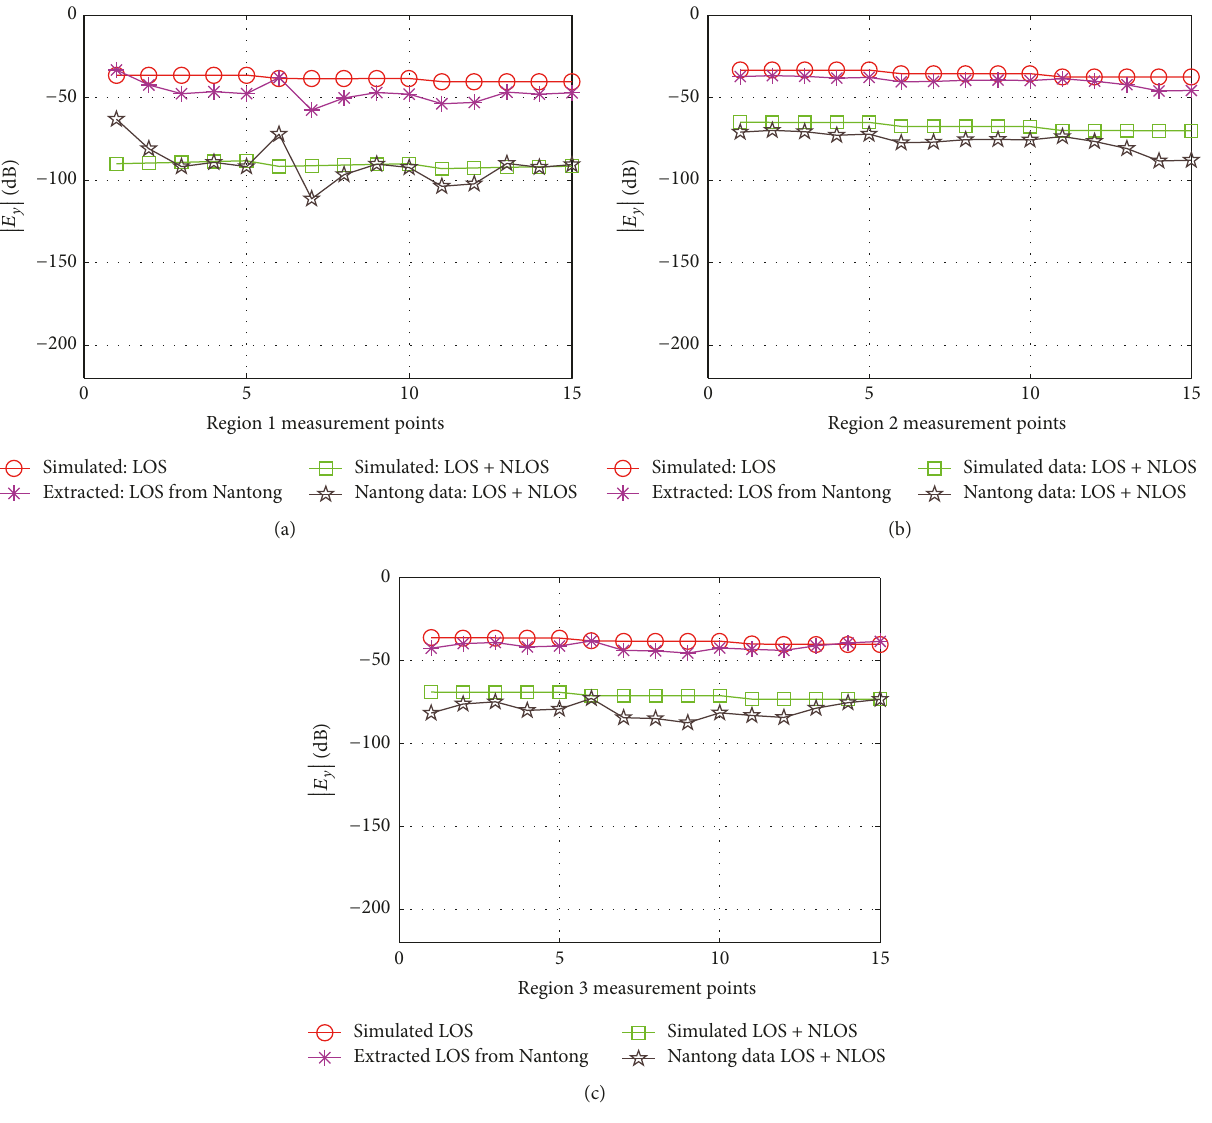
Figure 6: The distribution of 𝐸 𝑦 of horizontally polarized LCX for the LOS and NLOS paths and its comparison with the Nantong Tunnel different measuring locations such as in (a) Region 1, (b) Region 2, and (c) Region 3, respectively.